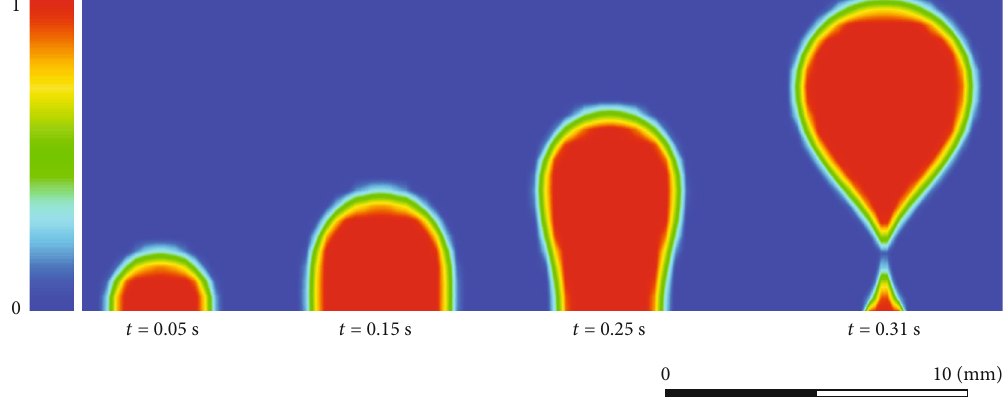
Figure 4: Bubble formation and escape processes.